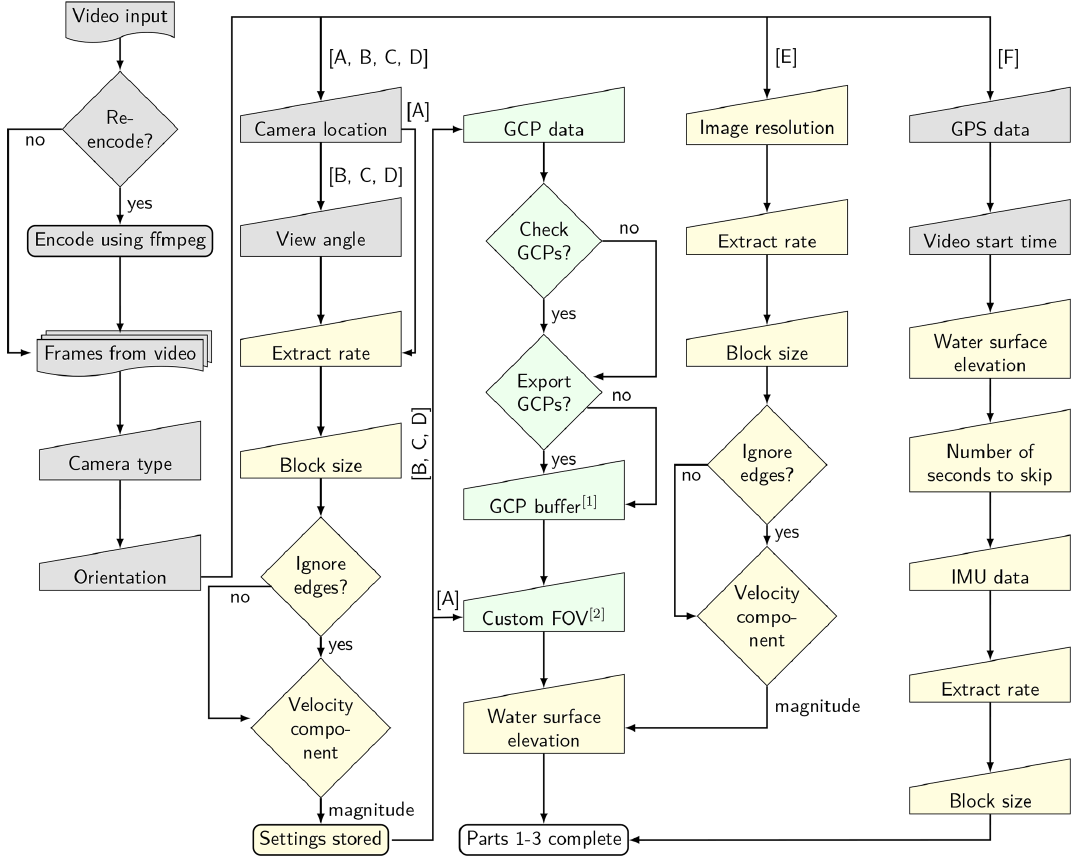
Figure 2. Workflow for Sect. 1–3 of KLT-IV v1.0. Different workflow scenarios are provided based on the choice of camera orientation. Letters correspond to the orientation defined in Table 1. Grey, yellow, and green colours relate to items within the (1) video inputs, (2) settings, and (3) ground control sections respectively. Notes: either the GCP buffer [1] or custom FOV [2] should be